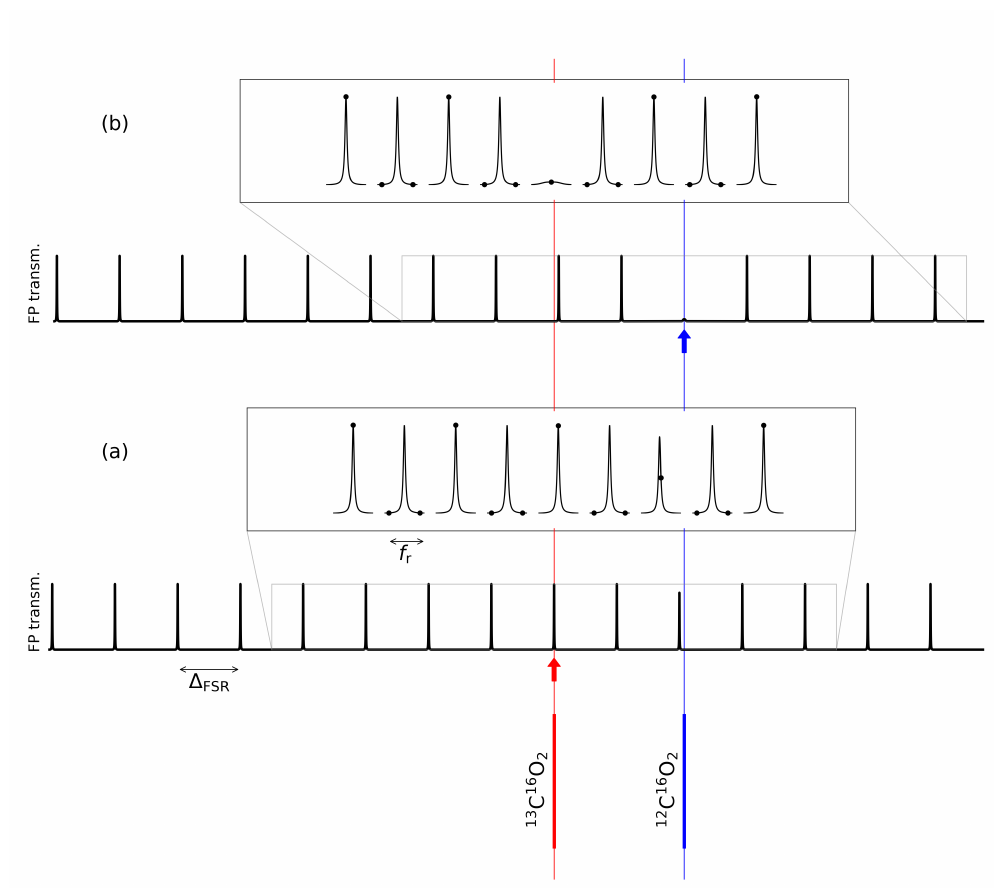
Figure 1. The two roto-vibrational transitions are probed around the two comb/FP configurations shown in figure, where the FP transmission as a function of frequency is shown in two cases. In case ( a ), one comb tooth and one FP mode are resonant with the 13 C 16 O 2 transition, while in case ( b ), they are resonant with the 12 C 16 O 2 transition. Far from resonances, the FP mode is an Airy function; around a resonance frequency, the mode is modified by the resonant refractive index of the FP medium. Here, the simulation is made by taking Voigt profiles for the two investigated transitions (Hitran parameters), and with f r = 400 MHz, ∆ FSR = 6.2 GHz (i.e., 2 ∆ FSR / f r = 31), and a FP finesse F = 200. In each inset immediately above the FP transmission, each FP mode is zoomed (broken axis plot). We observe that one FP mode every two transmits a comb tooth, and that between adjacent zoomed FP modes, there are 15 comb modes not transmitted and not shown in the inset. We observe that in the ( a ) case, both transitions are simultaneously probed by different comb teeth, the 13 C 16 O 2 transition giving an effect not visible in the graph. The ( b ) case shows a heavily saturated 12 C 16 O 2